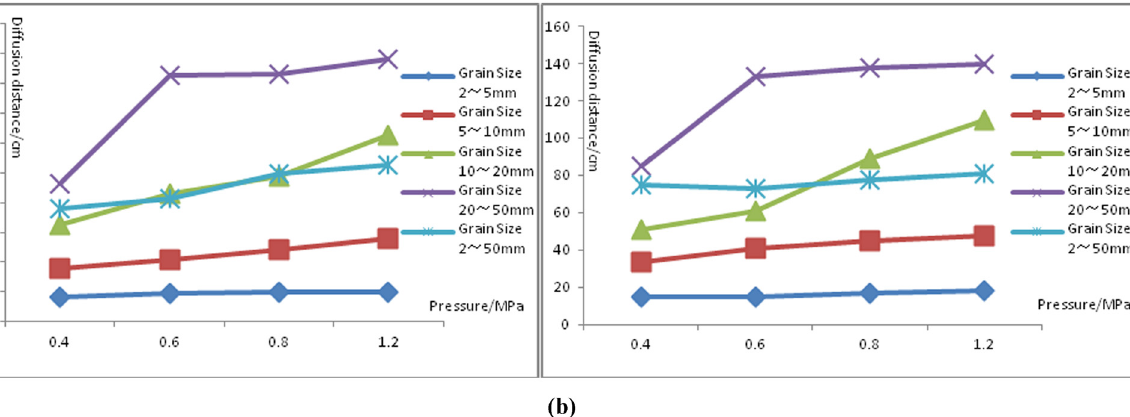
Figure 9: Diffusion distance of low - thermal asphalt slurry in the 1D experiment model: ( a ) gravel modelnot filled with water and ( b ) gravel model filled with water.